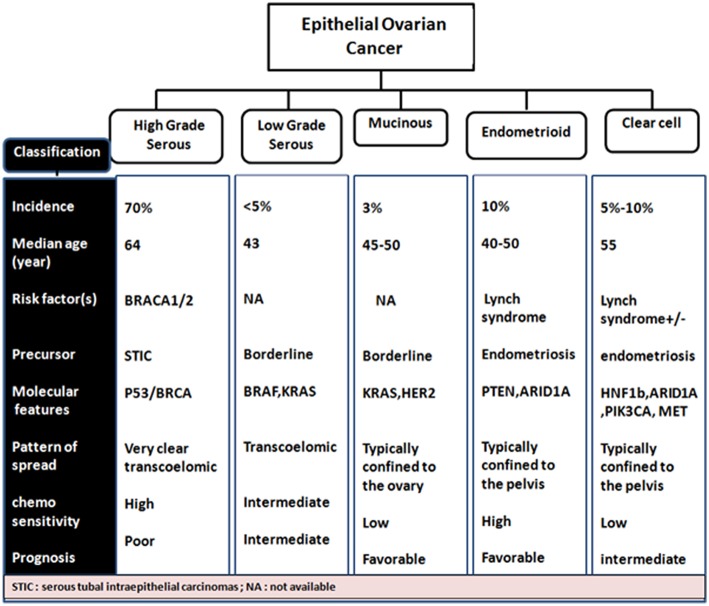
Phenotypic- genotypic classification of epithelial ovarian cancer subtypes.